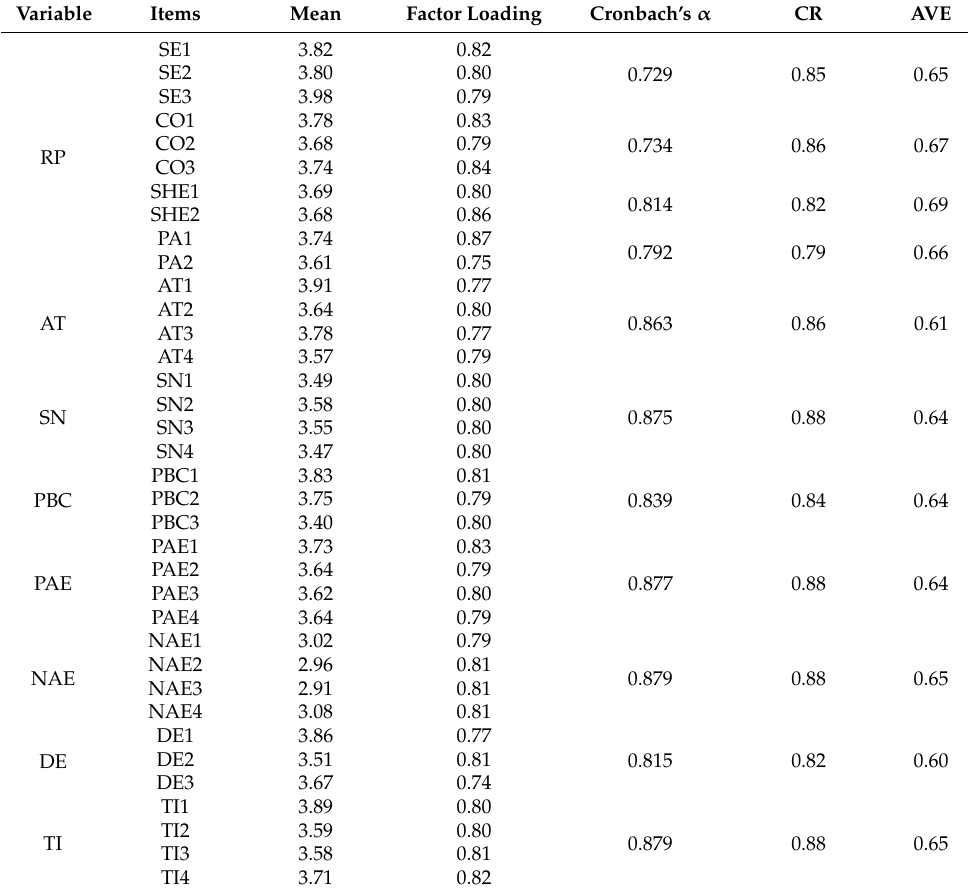
Table 1. Confirmatory factor analysis.